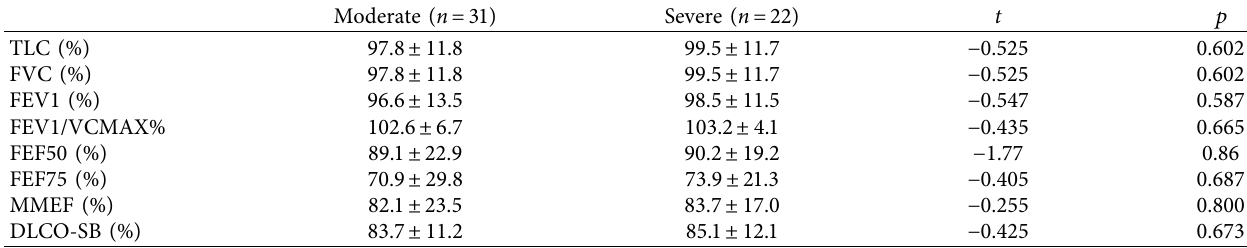
Table 3: Comparison of pulmonary function between moderate and severe patient